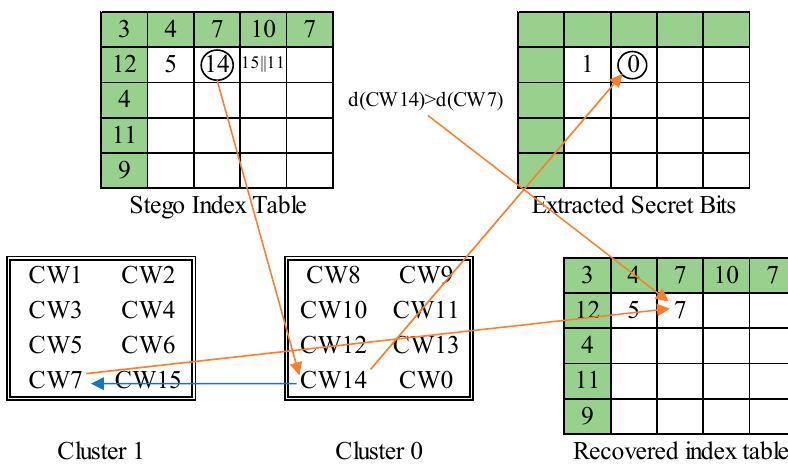
Figure 16. Extraction example 2: mismatched case.